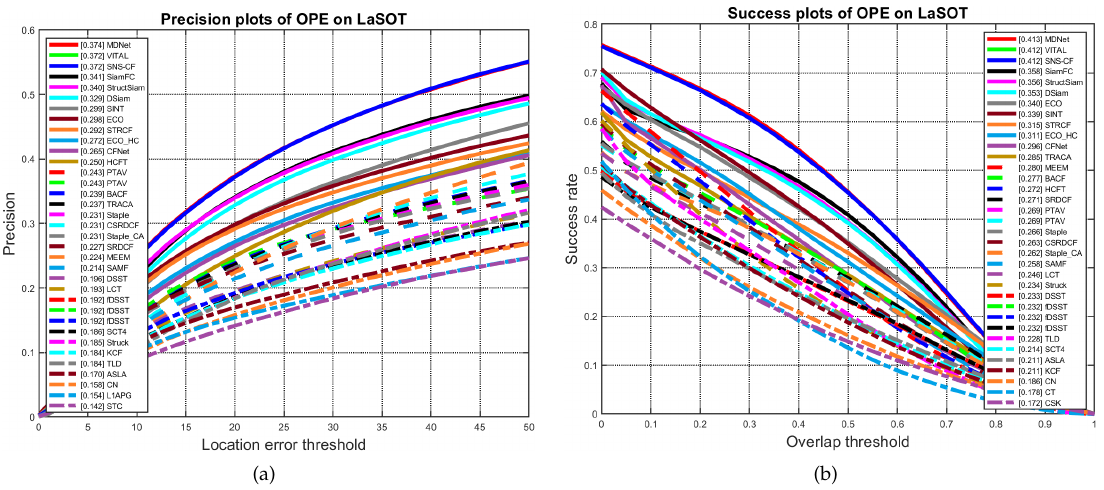
Figure 4. ( a ) Distance Precision and Overlap Success plots over 100 benchmark sequences using One-pass Evaluation (OPE) on both threshold scores at 20 pixels and ( b ) Area Under The Curve score (AUC) (right) on LaSOT [21]. Notice that the proposed algorithm (Blue) ranks third, with first three trackers MDNet [43], VITAL [44] and SNS-CF (ours) merely having the same performance. Extensive